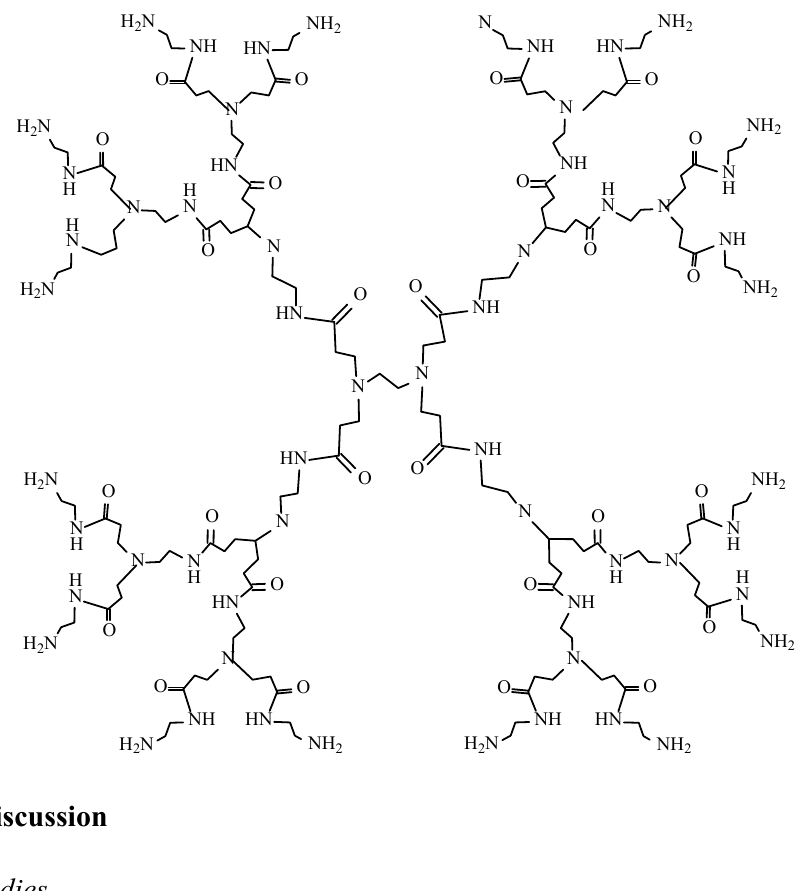
dendrimer generation 2